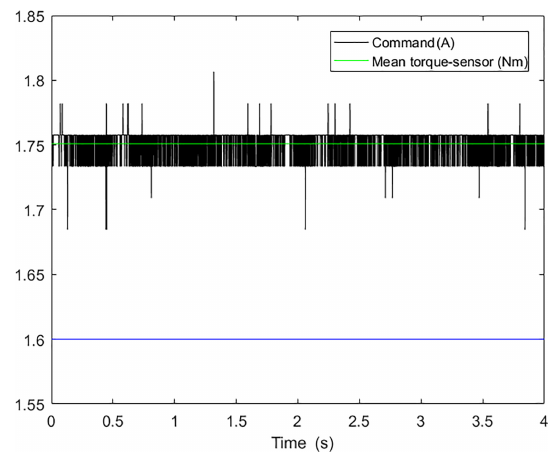
Figure 9. Ampere/torque analogy.